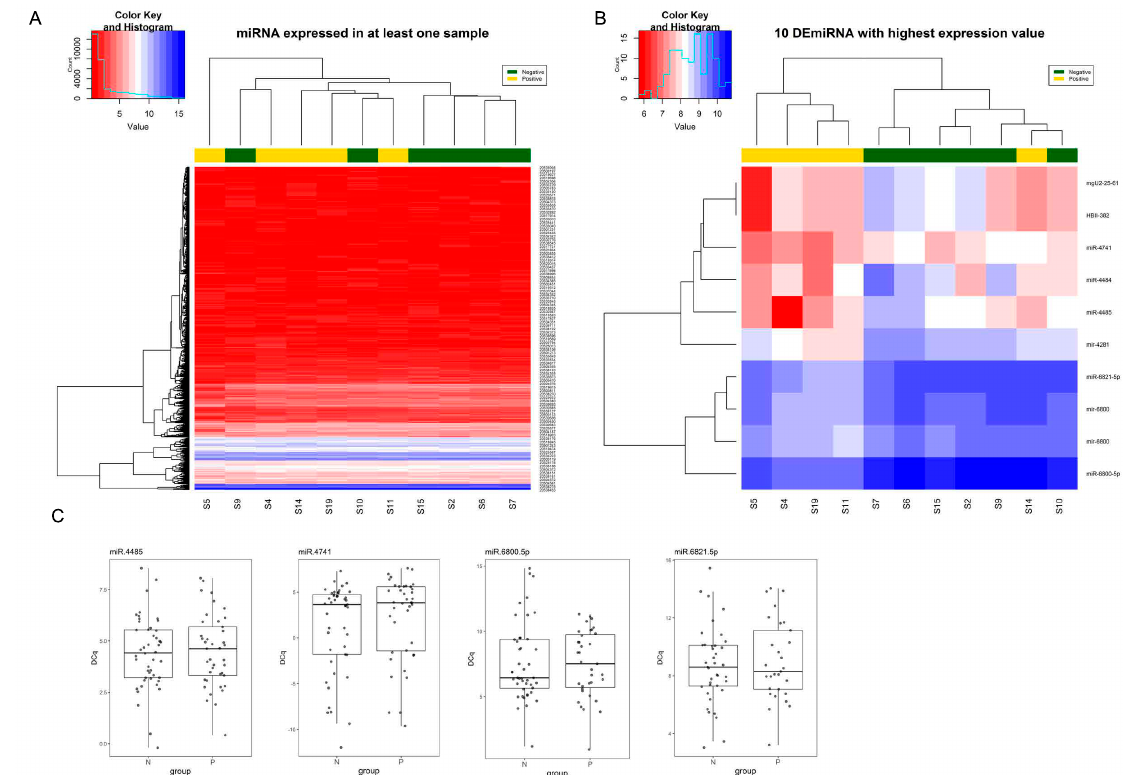
Figure 2. Results of miRNA expression profile by microarrays. ( A ) Heatmap showing the expression (microarray intensity signal) of miRNA that are expressed in at least one sample. ( B ) Heatmap of the expression of the ten DEmiRNAs showing the highest expression. Hierarchical clustering shows that the expression pattern of these ten miRNAs is able to group patients according to their LS-OCMBs status. ( C ) RT-qPCR validation results of selected candidate miRNAs. P—positive LS-OCMB status. N—negative LS-OCMB status. DE—di ff erentially